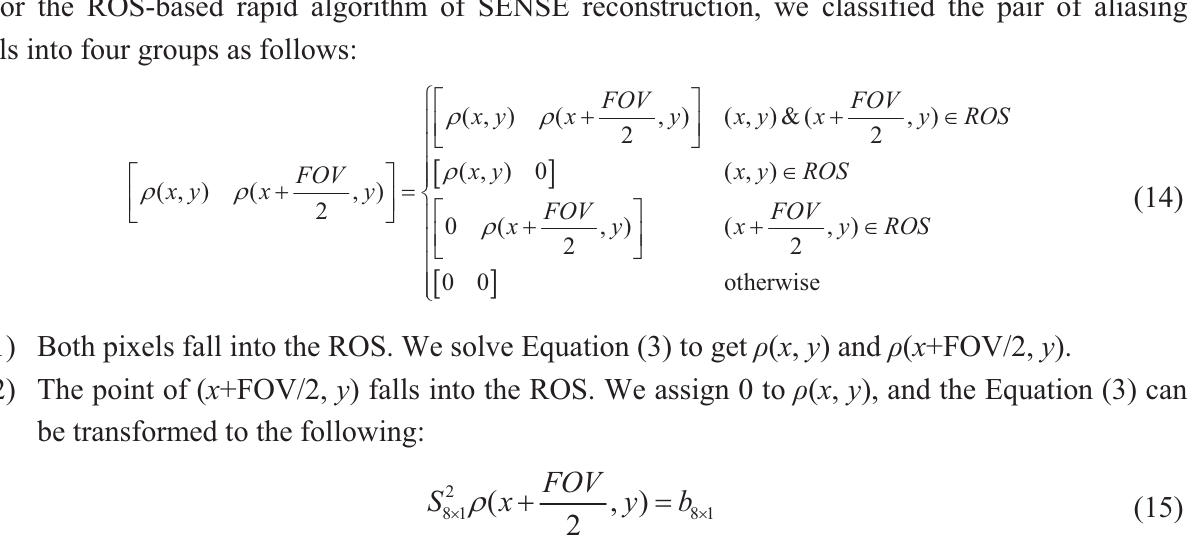
to D ); Ds within ROS; regressor 1 8 (shown also the S i